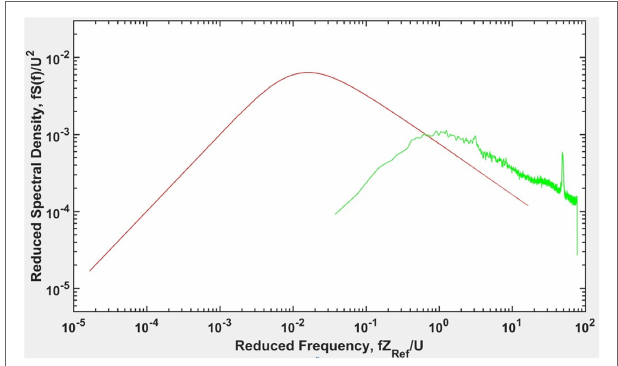
FIGURE 1 | Longitudinal wind spectrum at height of 2.3m (model scale) above wall of wind (WOW) floor for an open terrain.